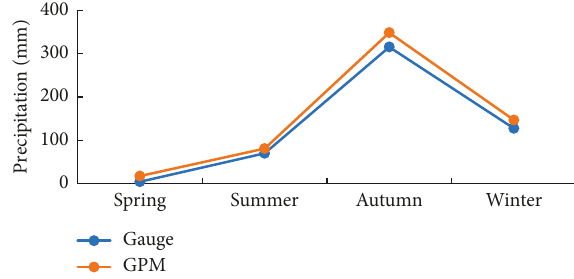
Figure 6: The average monthly rainfall of all gauges and GPM monthly